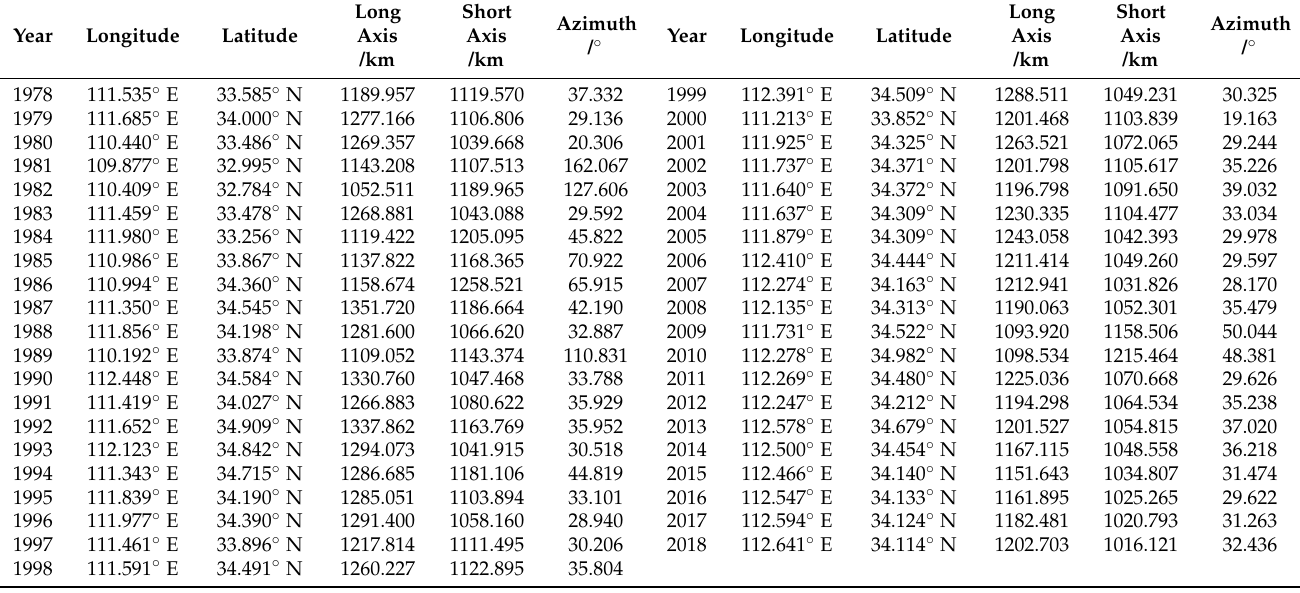
Table A1. The parameters of COG and SDE of APE over the